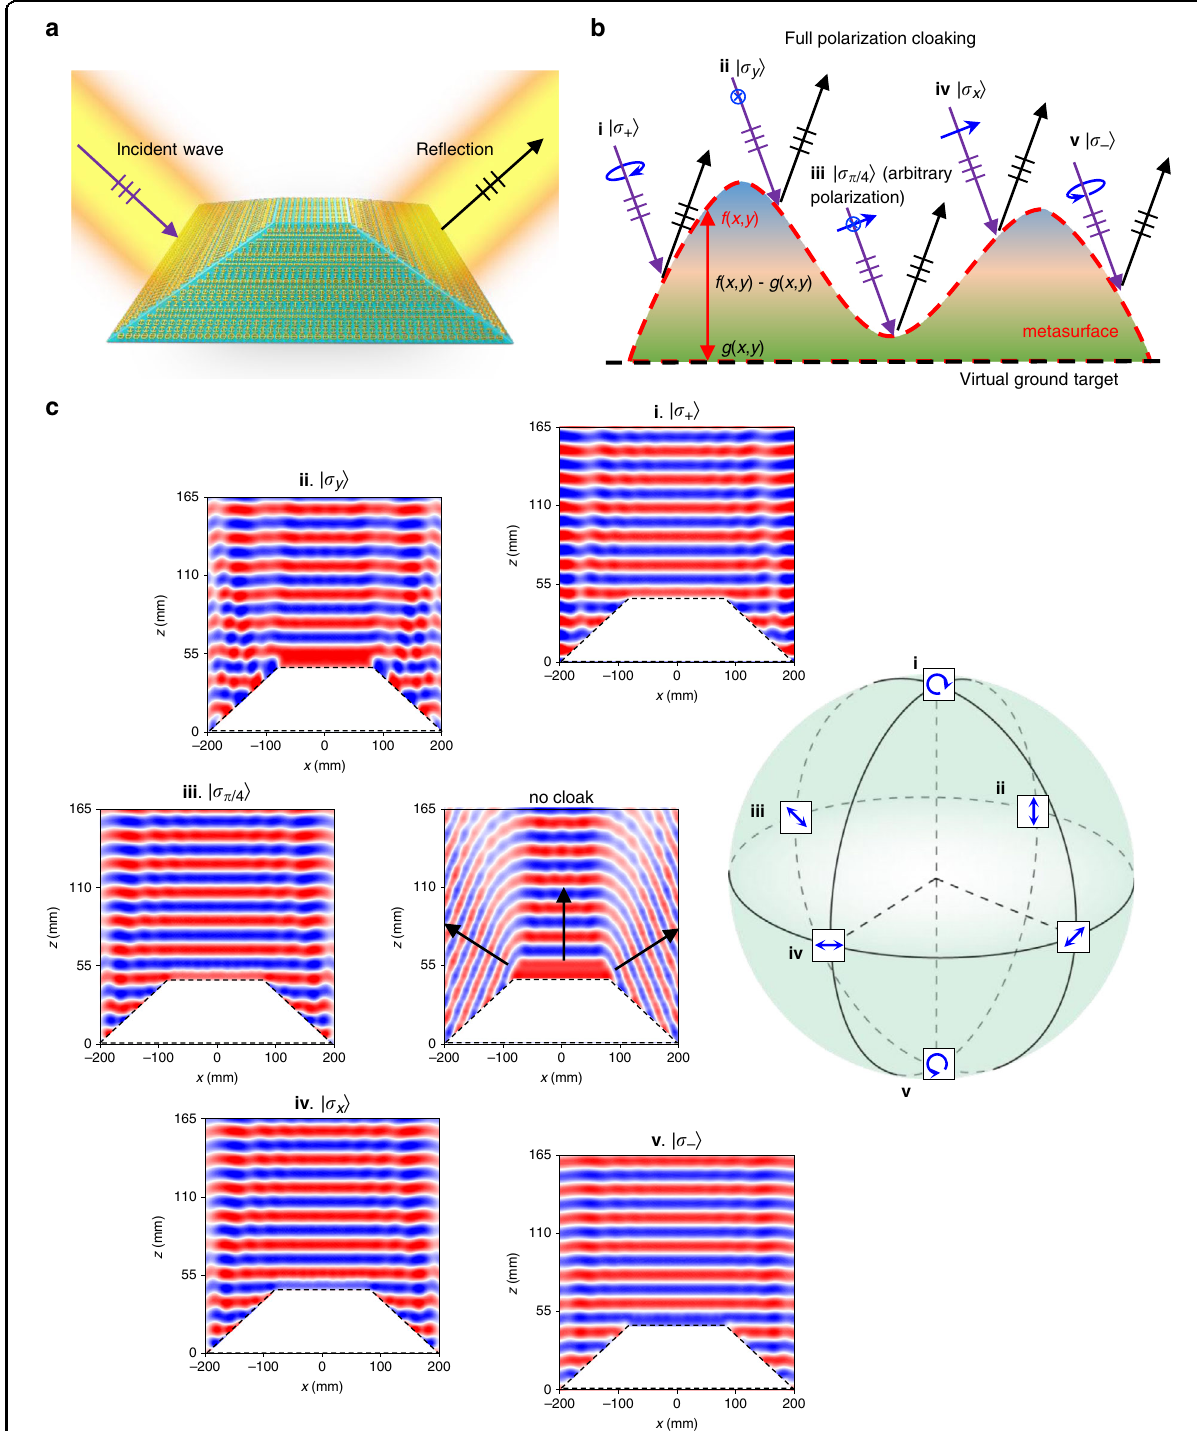
Fig. 1 The concept of full-polarization cloaking. a Schematic design of a metasurface cloak. b The schematic representation of full-polarization metasurface cloak. The arbitrary curved scatter is covered by a metasurface cloak. Under the incidence (purple arrows) of different polarizations, the wavefront (indicated by a triplet short line) can be reconstructed as if the wave experiences a specular re fl ection (black arrow) at a virtual ground plane. The red dashed line denotes the metasurface cloak at the boundary of scatter denoted by f ( x , y ); the black dashed line denotes the virtual ground denoted by g ( x,y ). c The Poincare sphere with different major polarizations denoted from i to v, corresponding to σ þ j i , σ y σ (cid:2) j i , respectively. The near- fi eld distributions represent the copolarized beam under the normal incidence of a trapezoid metasurface cloak with SOP from i to v and under the incidence of bare bump with SOP of σ x j i ,